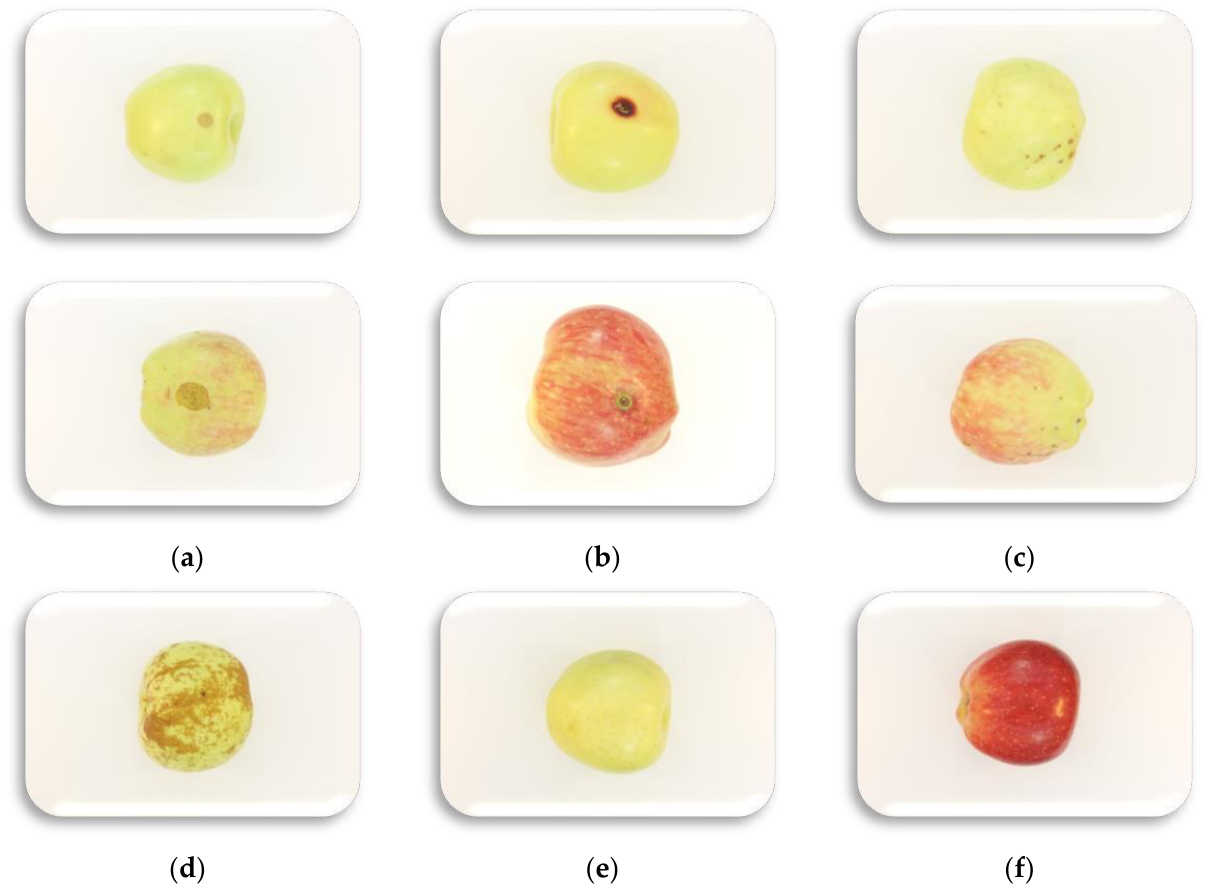
Figure 1. Images of healthy and infected apples with pests and diseases. ( a ) Apple capsid, ( b ) Cydia pomonella , ( c ) Stephannts pyri , ( d ) Apple rusting, ( e ) Healthy Golden Delicious, and ( f ) Healthy Red Delicious.